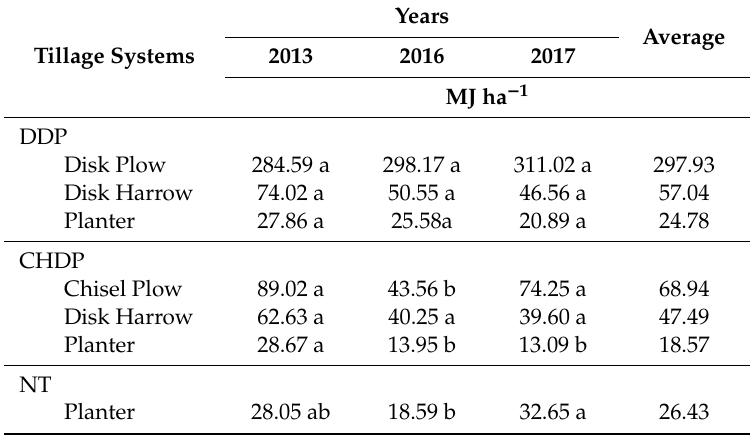
Table 6. Specific energy per area used at each labor for the di ff erent tillage